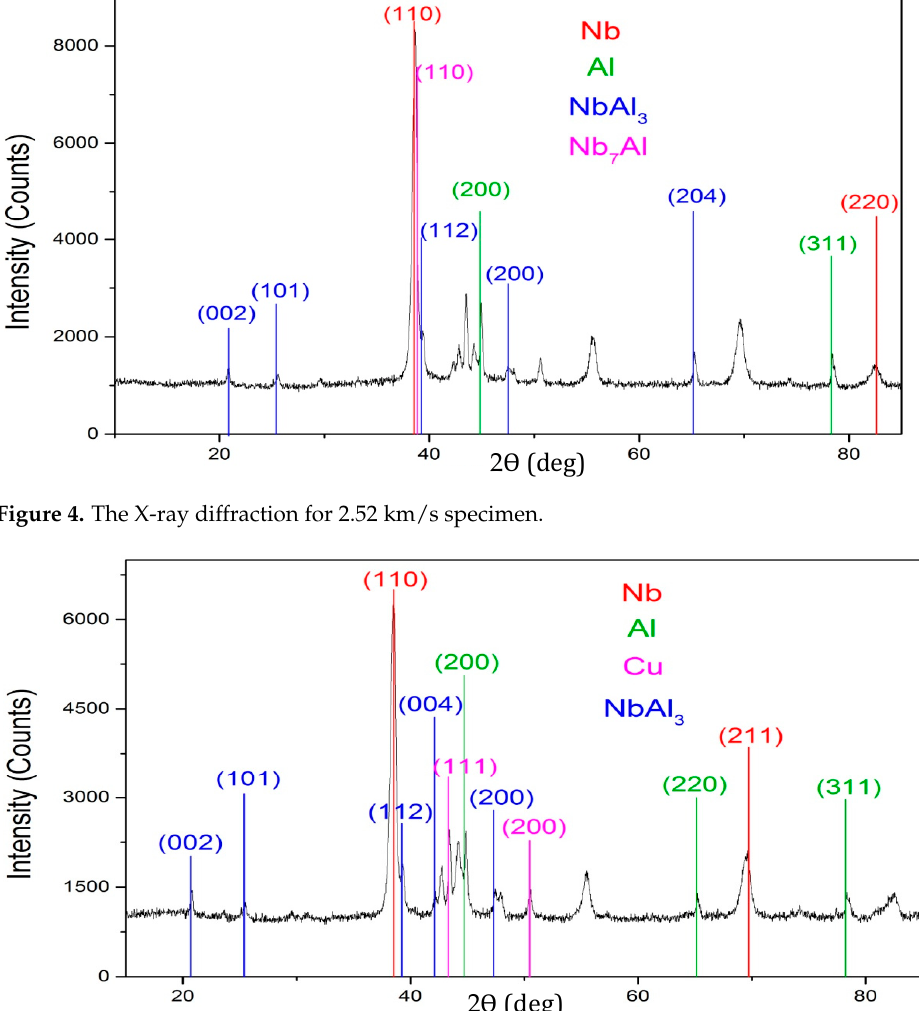
( c ) Figure 6. The atomic displacement of Nb-Al systems in plane for ( a ) NbAl 3 (112), ( b ) Nb 7 Al (110) and ( c ) Nb (110), where the light blue is Nb, the purple is Al and the red consists of 1.725 Nb and 0.25 Al. The crystal structures reveal that the crystal transition from cubic to tetragonal is ax- ial under impact. When the impact pressure increased, the Nb and Al atoms moved axi- ally, where the atoms were in plane (110) along direction [001]. The pure cubic metals transferred to Nb 7 Al retained the cubic structure, and those transferred to NbAl 3 became tetragonal in structure. In all, those planes had strong diffraction peaks and they did not change under impact, revealing that the NbAl 7 and Nb 3 Al alloys are easy to be synthe- sized from pure Nb and Al under shock waves. This is evidence to support our experiment results. Although the diffraction angles of certain crystal planes were almost equal be- tween Al and Nb and Nb-Al alloys, the alloying process in general powder metallurgy is based on atomic diffusion, and the same is true for the shock compression of powders.